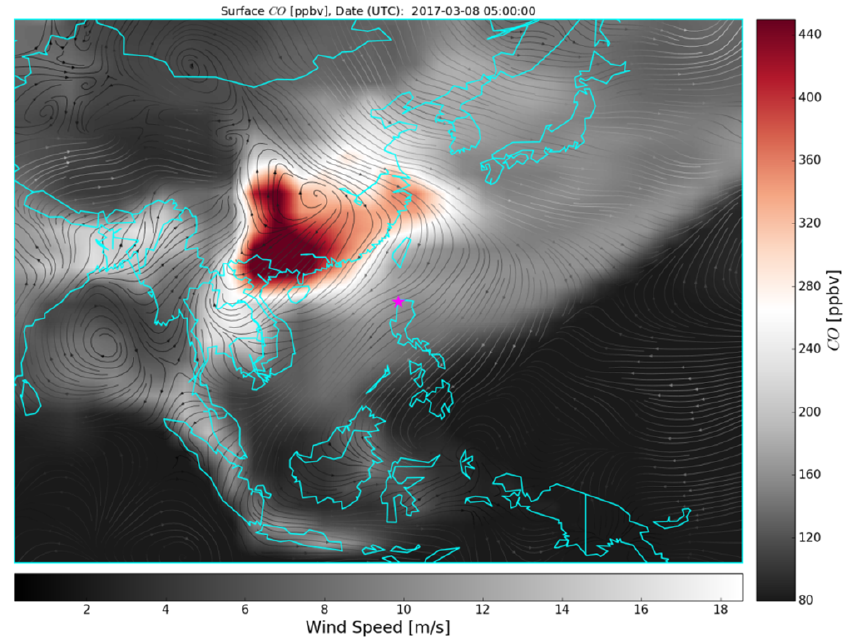
Figure 8. Surface CO (color shaded from black to red) from the GEOS Chem model simulated on 8 March 2017 at 05:00 UTC. The Philippines is right in the middle of the interface where the clean Western Pacific air (dark shade to black) meets the East Asian outflow of elevated CO . Wind speeds and direction are shown as streamlines. The location of the TCCON station in Burgos is marked by the magenta